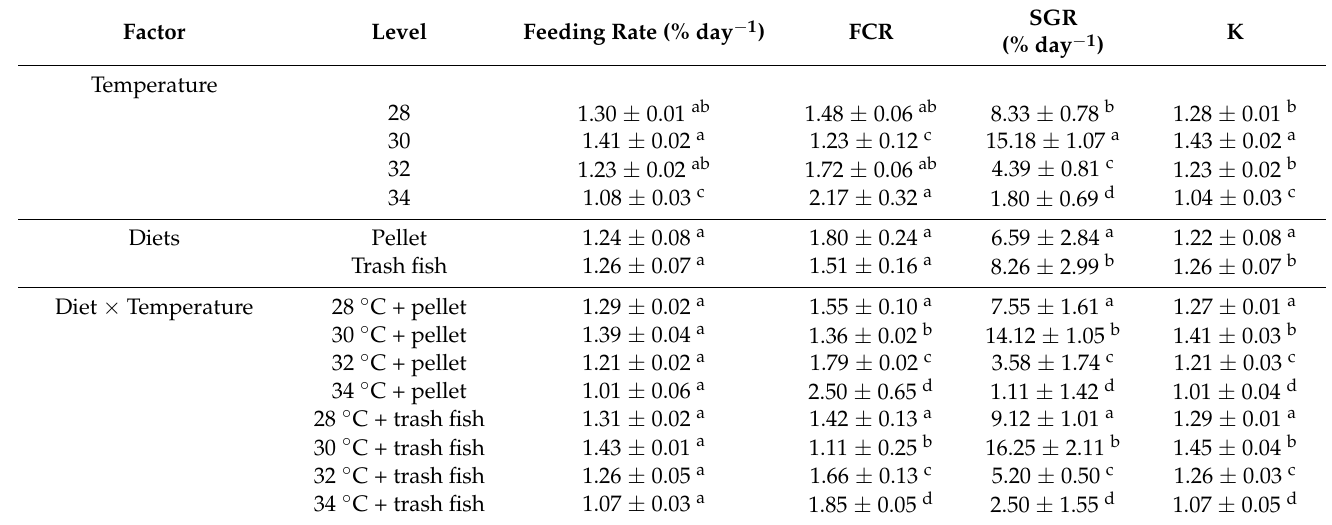
Table 3. Means of feeding rate, FCR, SGR, and K of hybrid Sabah grouper after 30 days of experimental period (mean ± SD).